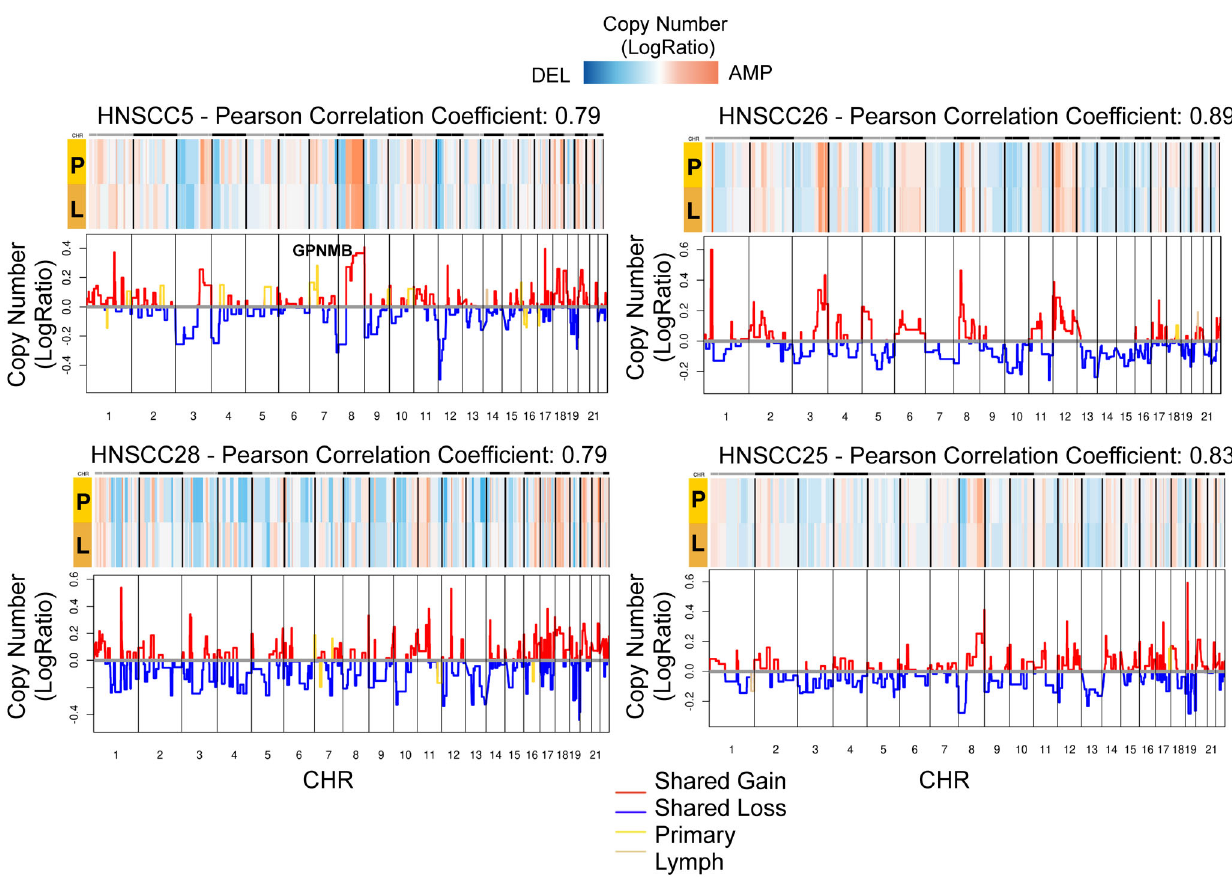
Fig. 7 | Clonal copy number comparison of matched primary and metastatic tumor. Copy number pro fi le of primary (P) and metastatic lymph nodes (L)